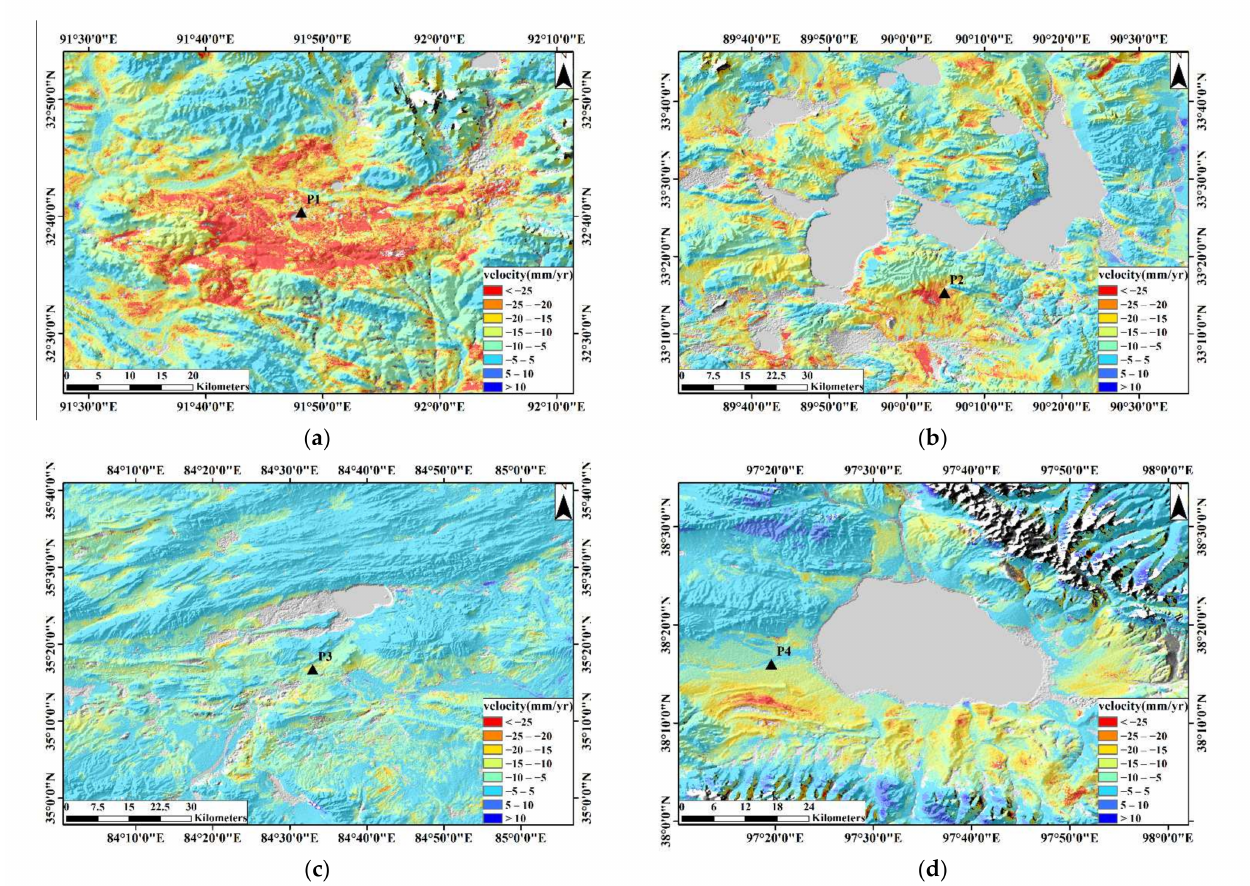
Figure 5. The results of linear subsidence rate in local areas. ( a – d ) are the local areas of P1, P2, P3 and P4, respectively.